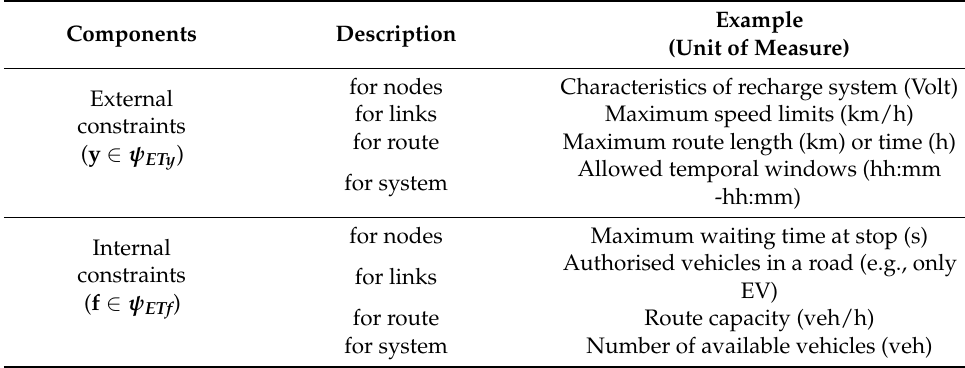
Table 6. External and Internal (ET)